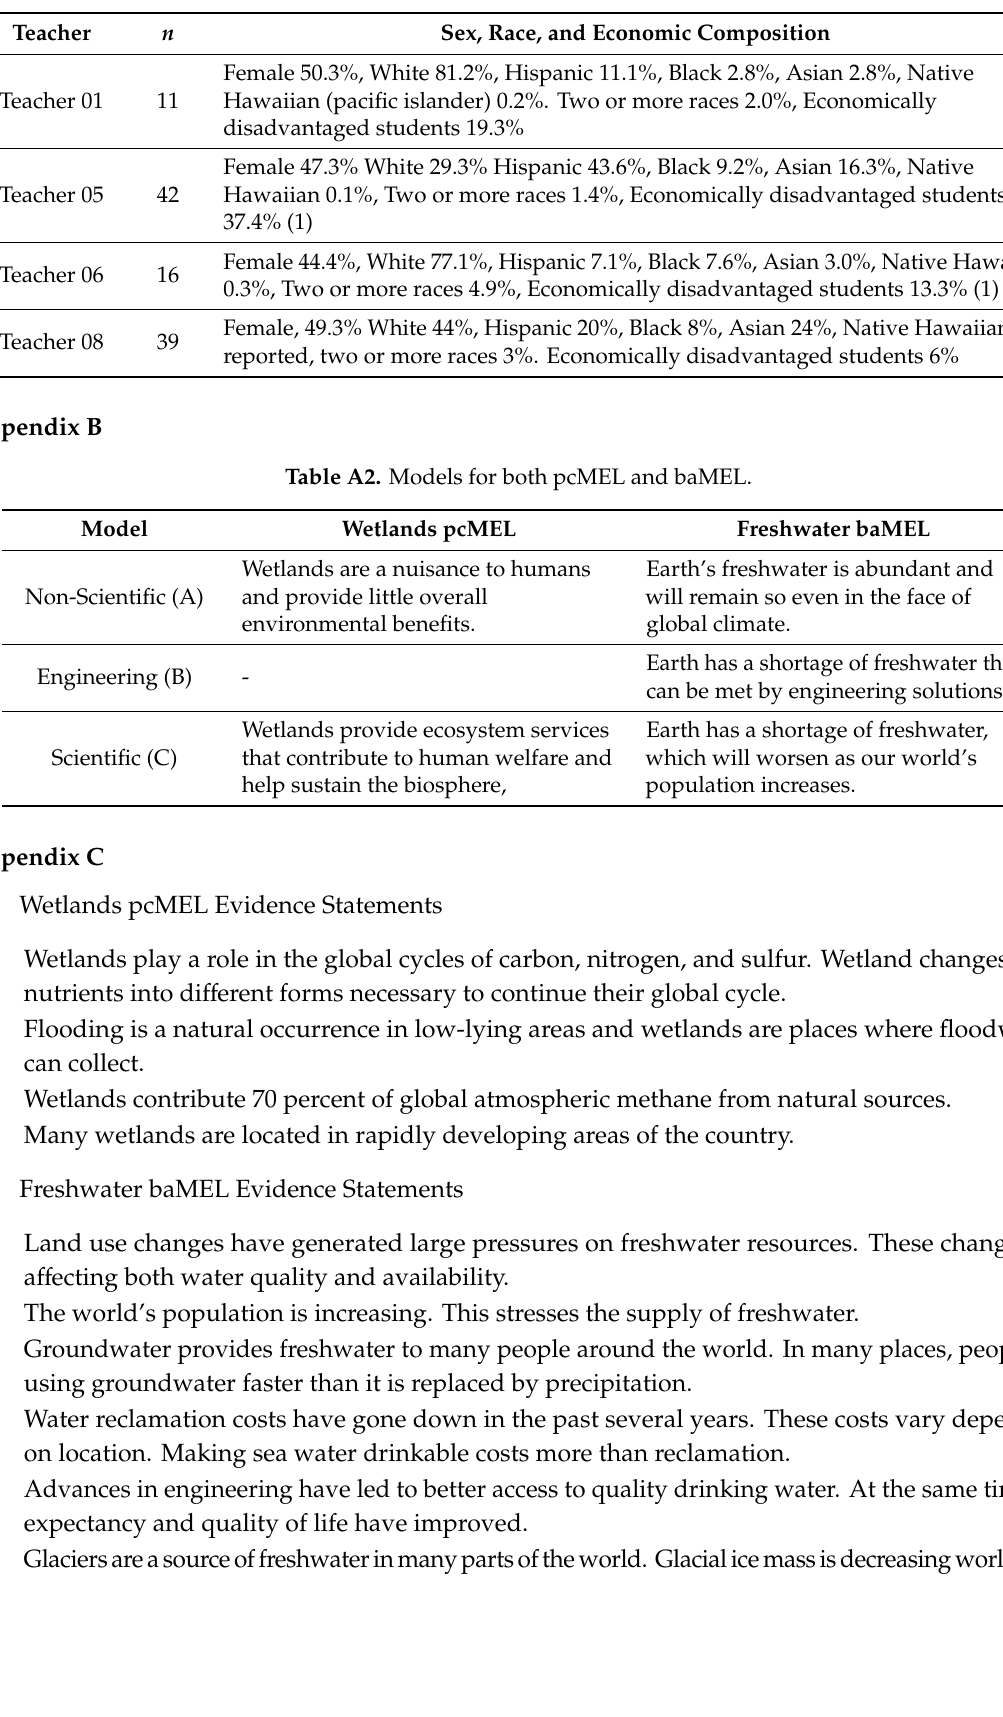
Table A1. Racial and ethnic compositions of each school.